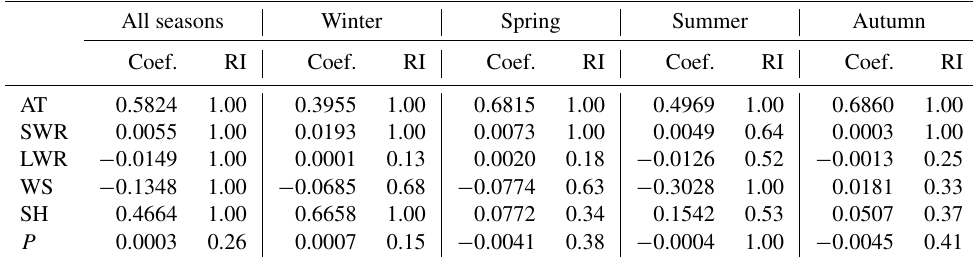
Table 3. Generic response for the five average models. All seasons Winter Spring Summer Autumn Coef. RI Coef. RI Coef. RI Coef. RI Coef. RI AT 0.5824 1.00 0.3955